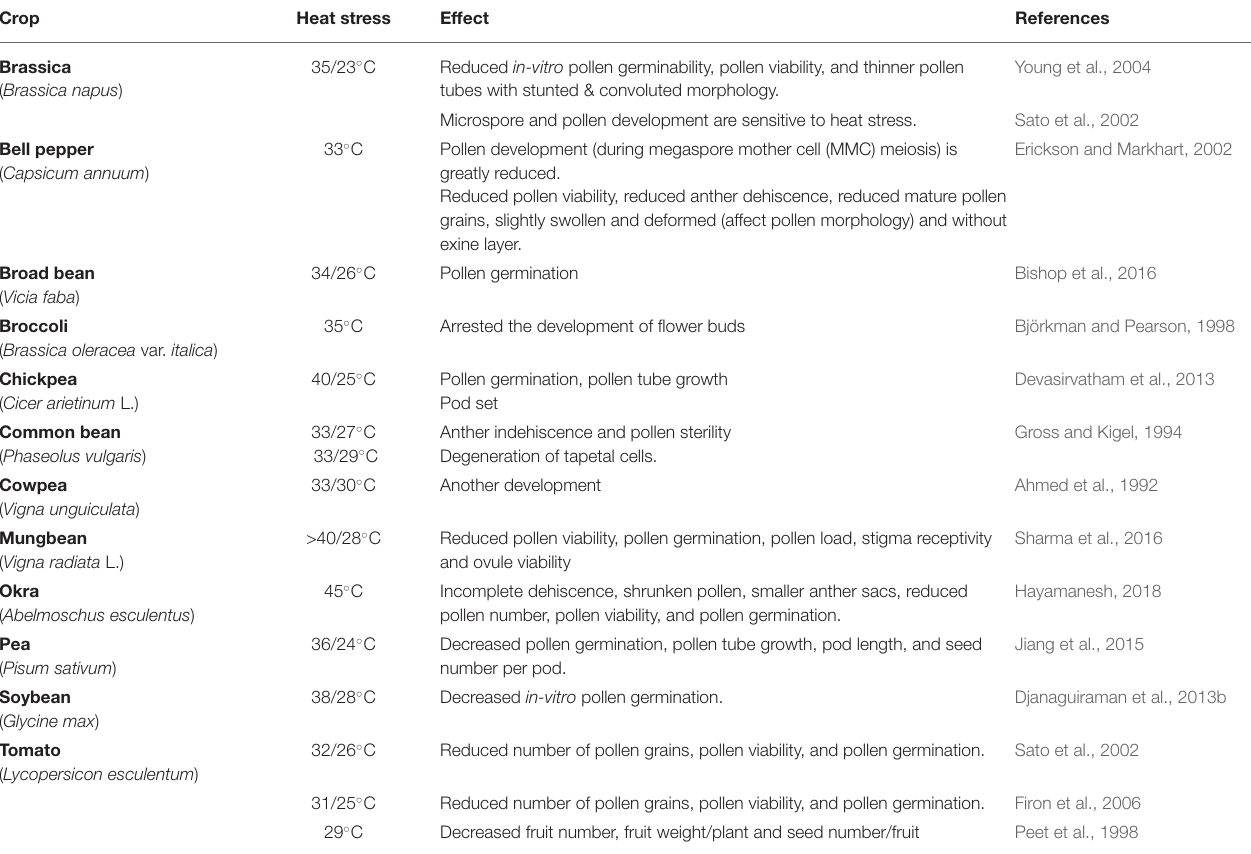
TABLE 3 | Effect of heat stress on reproductive tissues of some vegetable crops.